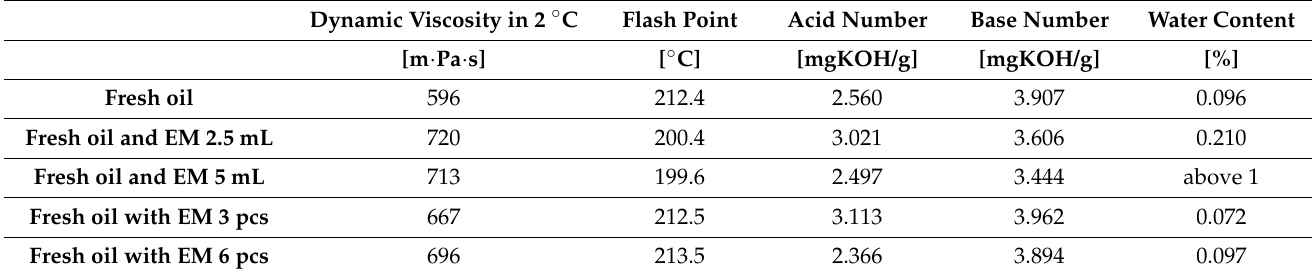
Table 2. Comparison of the parameters of new oil with and without effective